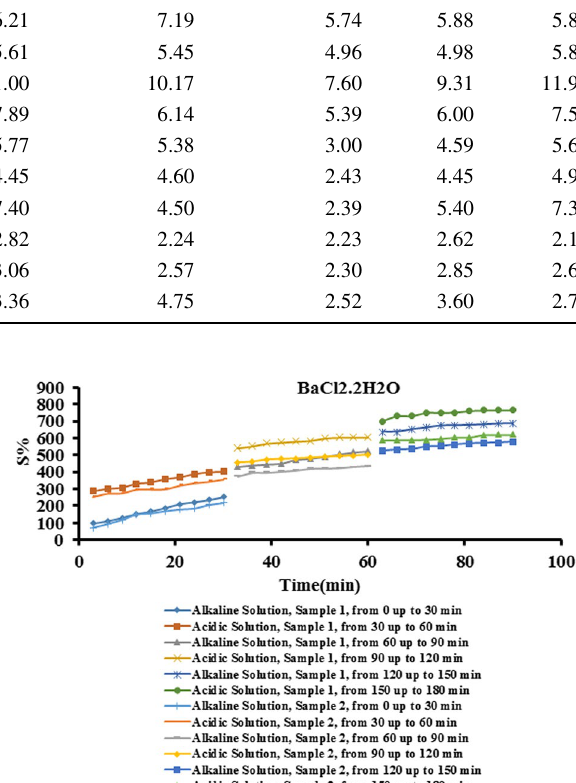
Table 2 Maximum equilibrium swelling percentage of PPG samples